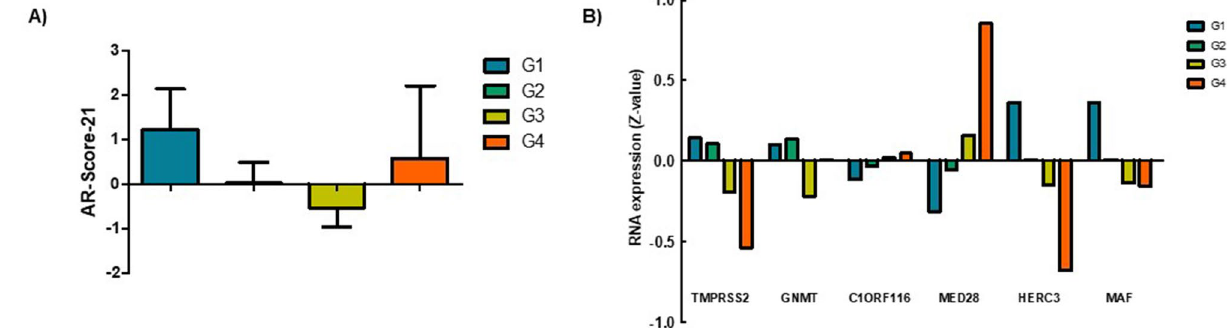
Figure 4. ( A ) AR-Score-21 in each histological grade. No statistical differences were identified between groups. Bars represent the mean of AR-Score-21 values, and whiskers the standard deviation in each histological grade. ( B ) Expression profile of the genes that show differences among histological grades. Bars represet the mean normalized expression of the indicated genes in each histological